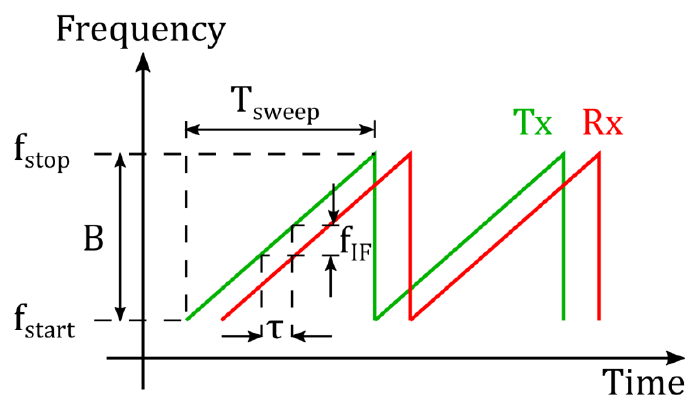
Figure 1. Frequency modulated continuous wave (FMCW) radar principle.